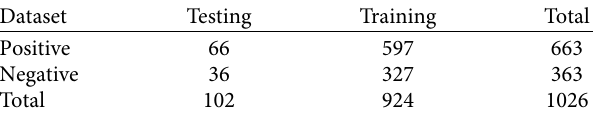
Table 1: The conspiracy dataset